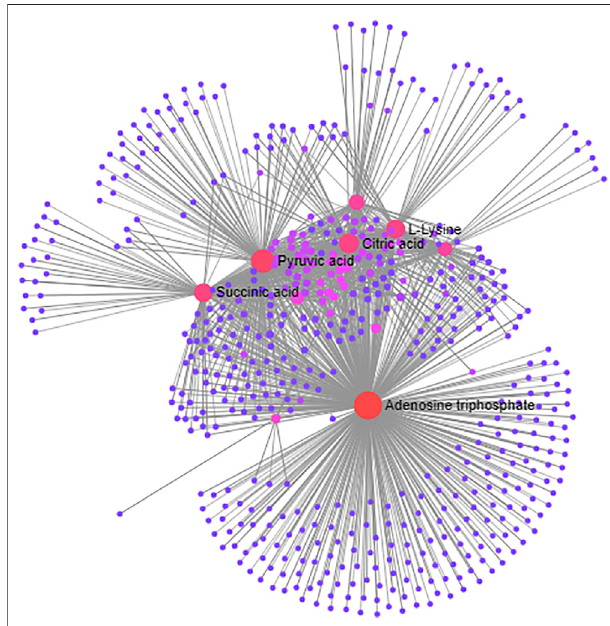
FIGURE 11 | The KEGG global metabolic network analysis of differentially expressed biomarkers based on multiple in fl uencing factors and multi-omics analysis.